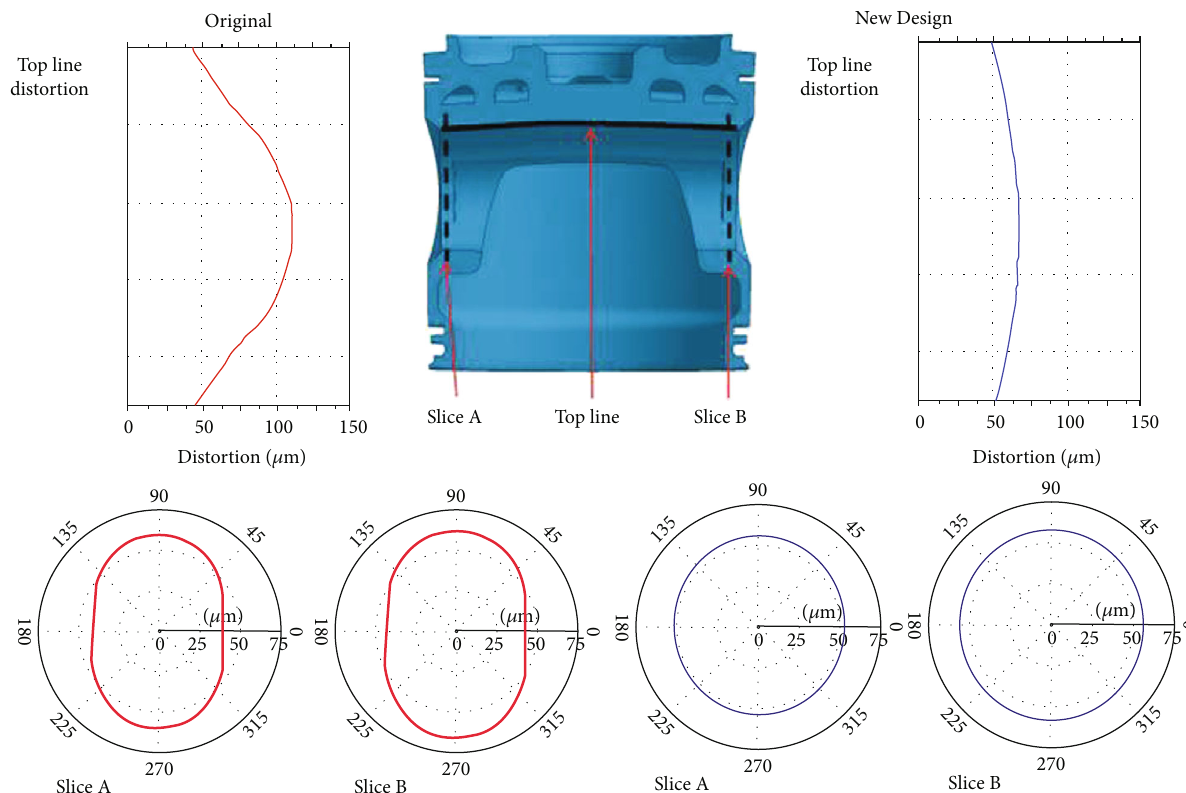
Figure 14: The comparison of deformation amount of the piston pin bore between the original design and the new